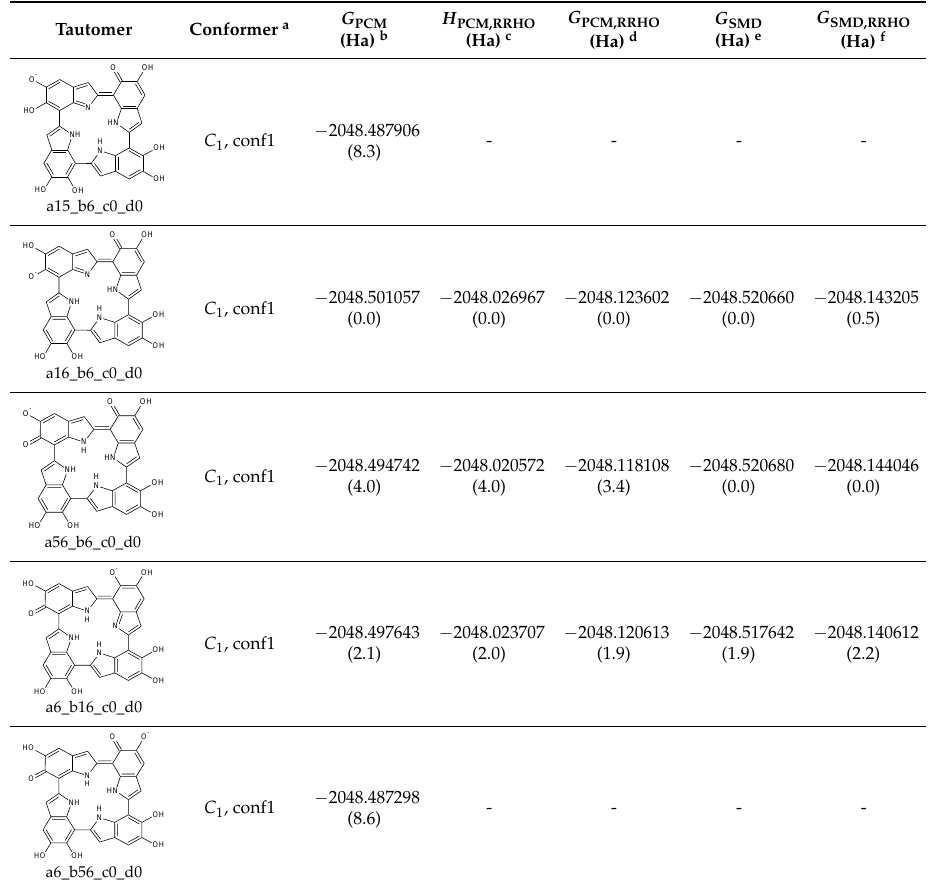
Table 9. KP-2e, monoanionic form in water.